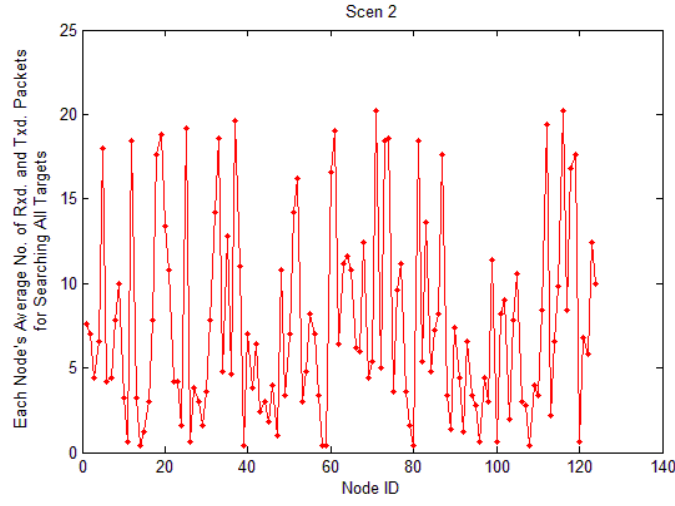
Figure 21. Average load of each node in Scenario 2.